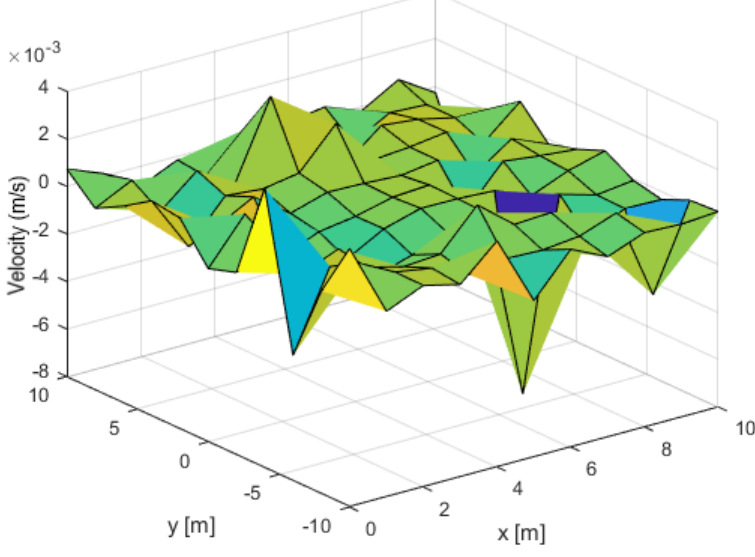
Figure 2. Porosity distribution profile generated using random probability density function. [ denotes that the variable has no unit.